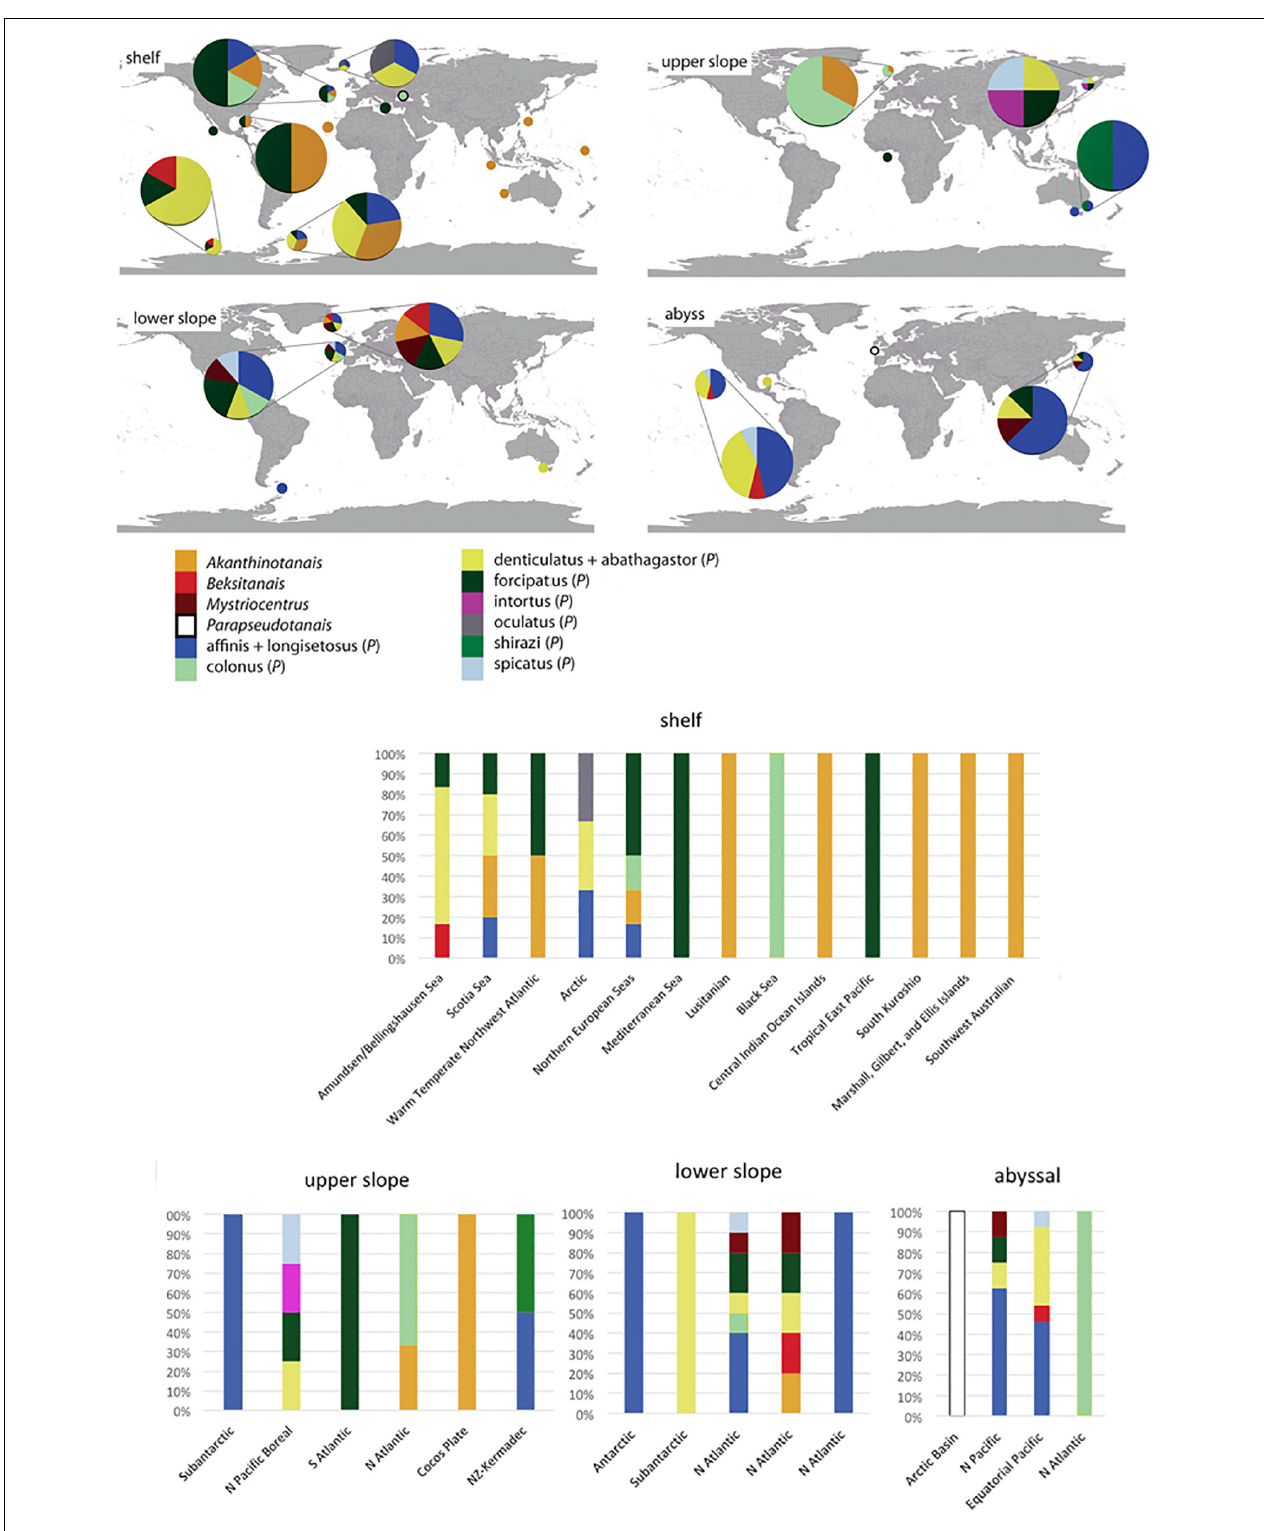
FIGURE 13 | Distribution of pseudotanaid genera and morpho-groups according to Bird and Holdich (1989b) and McLelland (2007) (for details see Table 2 ). The zoogeographical and bathymetrical classification according to Spalding et al. (2007) and Watling et al. (2013). The size of the pies corresponds to the number of species